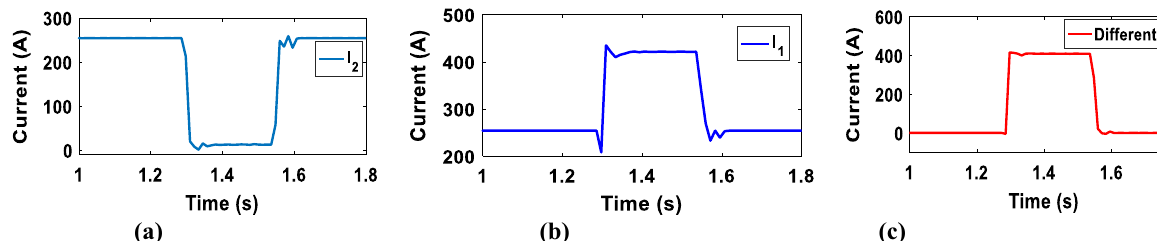
Fig. 4 Cable currents under fault condition a I 2 current, b I 1 current, c differential current